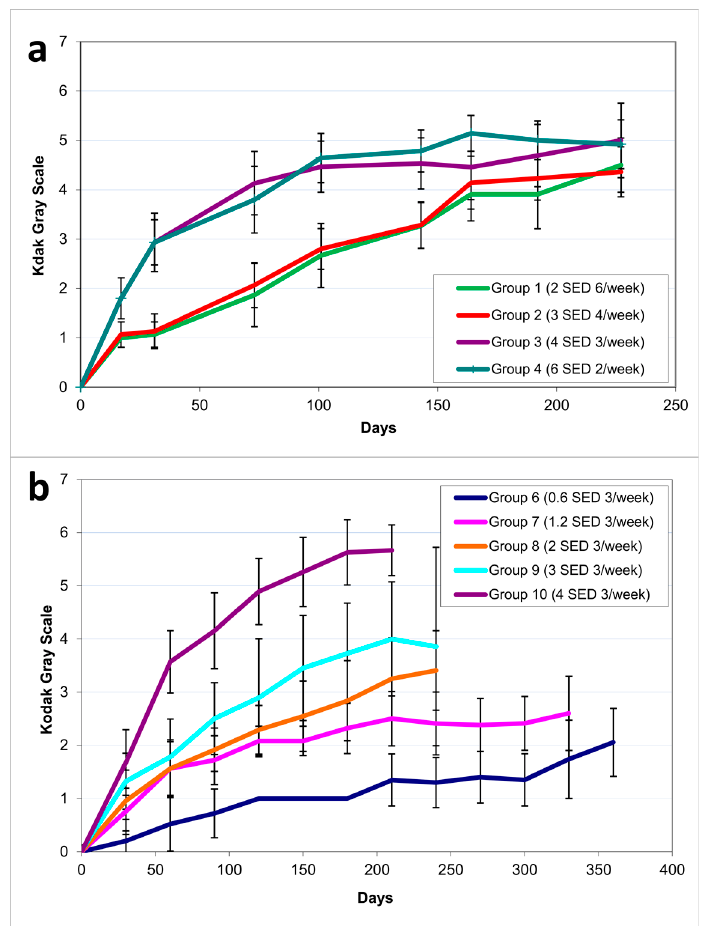
Figure 3. Mean development in pigmentation during ( a ) Dose–delivery study (Groups 1–4); ( b ) Dose–response study (Groups 6–10). Error bars indicate ± standard deviation (SD).